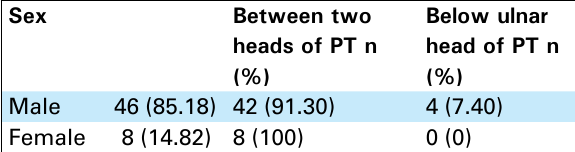
Table 2. Showing sex distribution of course